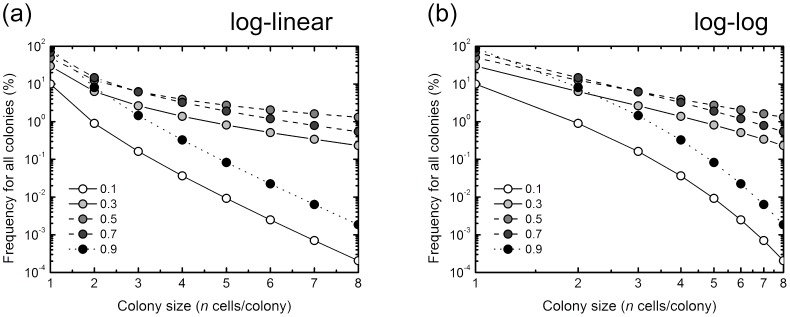
Mock examination of the branching dynamics with a probability of reproductive cell death (P1) on the log-linear plot (a) and log-log plot (b).The same P1 value at all branch points of the cell lineage was assumed, and Freq (occurrence frequency of abortive colony with n cells) was calculated. P1 ranged from 0.1 to 0.9.